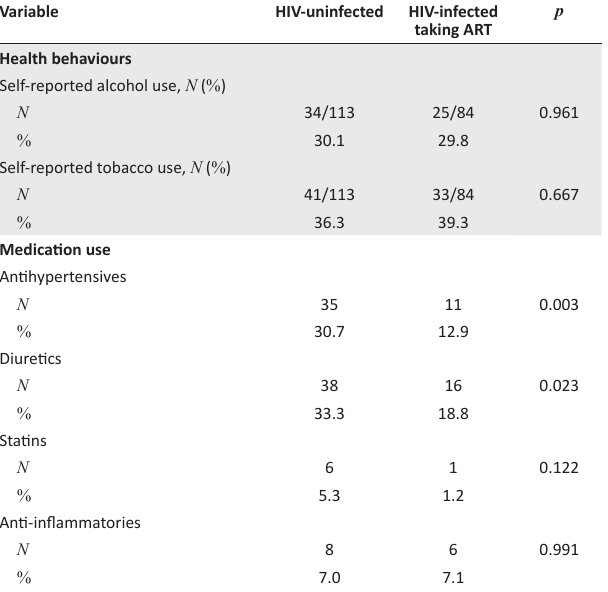
TABLE 2-A1 (Continues...): Characteristics of the HIV-uninfected and HIV-infected individuals taking antiretroviral therapy.